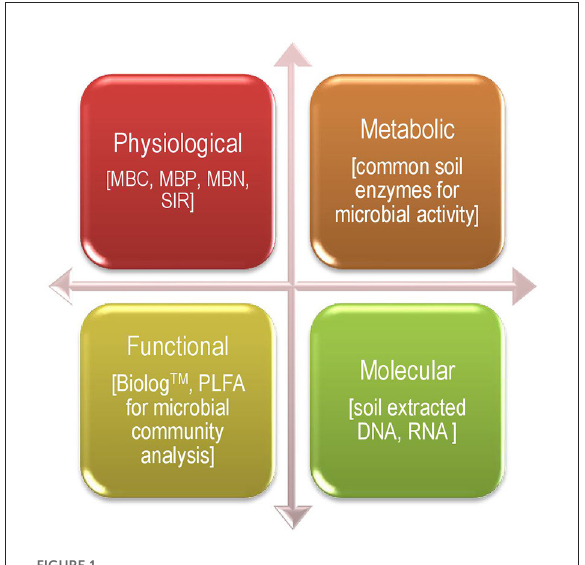
FIGURE1 Soil bio-indicators as classified on the basis of techniques of